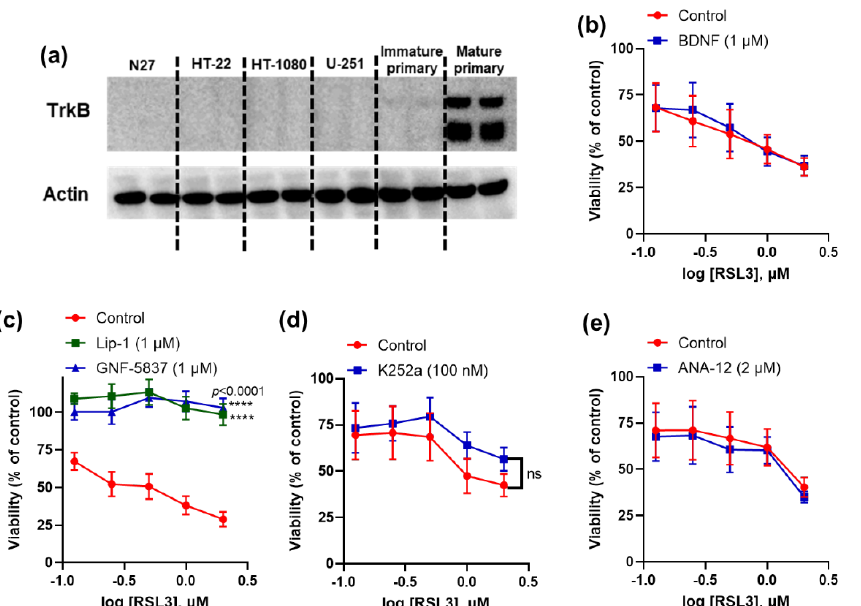
Figure 1. Activity of TrkB modulators against ferroptosis in mature primary cortical neurons. Im- munoblot shows TrkB expression in mature primary cortical neurons ( a ). GNF-5837 inhibits (while other TrkB modulators do not affect) RSL3-induced ferroptosis in primary cortical neurons ( b – e ). Cells were co-treated with ferroptosis inducer RSL3 and tested compounds for 24 h. Cell viability was measured by 3-(4,5-dimethylthiazol-2-yl)-2,5-diphenyltetrazolium bromide (MTT) assay. Data points signify mean percentage survival relative to untreated controls ± SEM, n = 9 – 10 from 2 – 3 independent experiments. p values were calculated using the two-way ANOVA (Dunnett's multiple comparisons test, ( c ) and the unpaired t-test ( d ), and the significant level is noted as **** p < 0.0001 (vs. control).